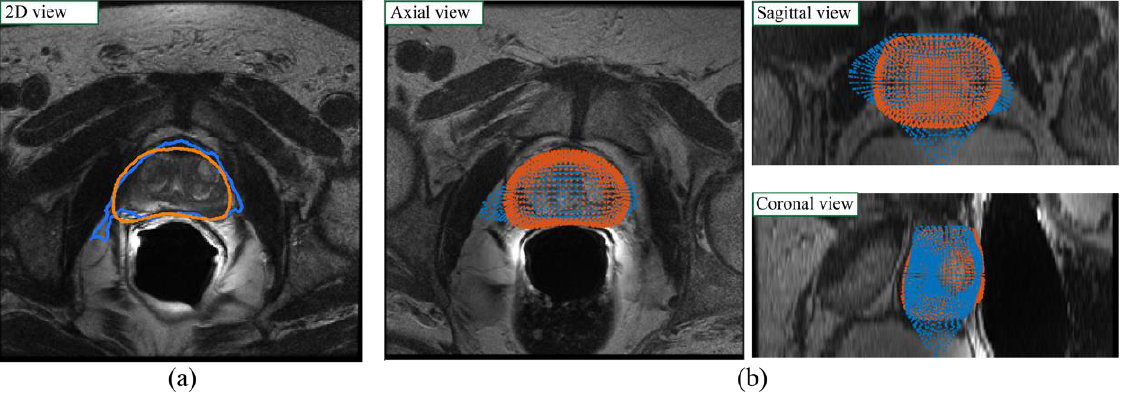
Figure 6. Visual performance of the proposed method before (blue) and after (red) the ASM model. The blue contours represent the output of the VNet-T2 network while the orange contour is the result obtained with the combination of the VNet-T2 network and the ASM model (VNet-T2 + ASM-2). ( a ) 2D view; ( b ) 3D view in the axial, sagittal, and coronal planes. The introduction of the active shape model to refine the prostate contour increased the accuracy of the gland segmentation especially in the base and apex zones.